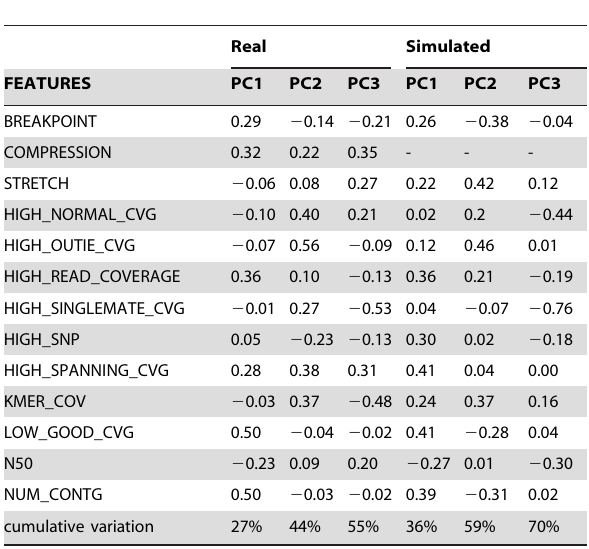
Table 1. More Informative Principal Components For Long Reads.